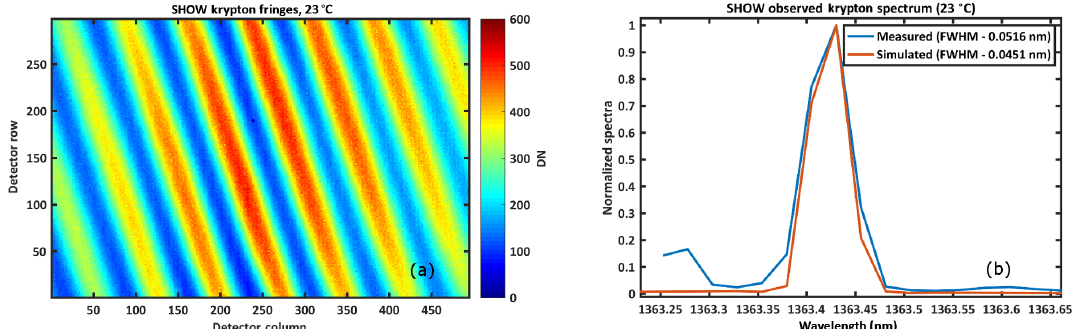
Figure 6. Krypton fringes observed with the SHOW SHS instrument at 23 ◦ C (a) and the spectrum obtained by taking the FFT of the interferogram at row 150 (b) . The measured spectra is shown in blue and the simulated spectrum is shown in